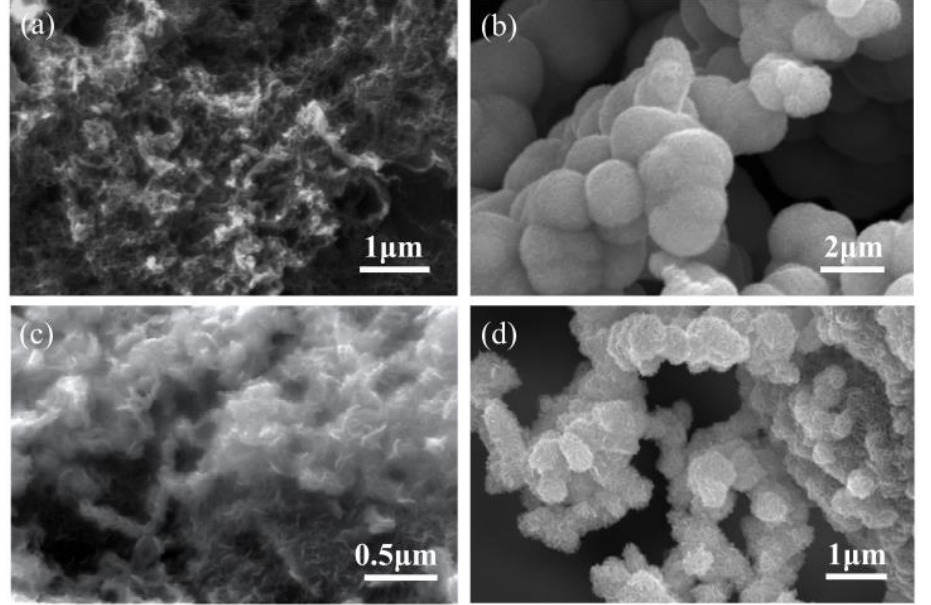
Figure 2. SEM image of ( a ) CGF, ( b ) bare MoS2, ( c ) s-MoS2@CGF, and ( d ) f-MoS2@CGF.